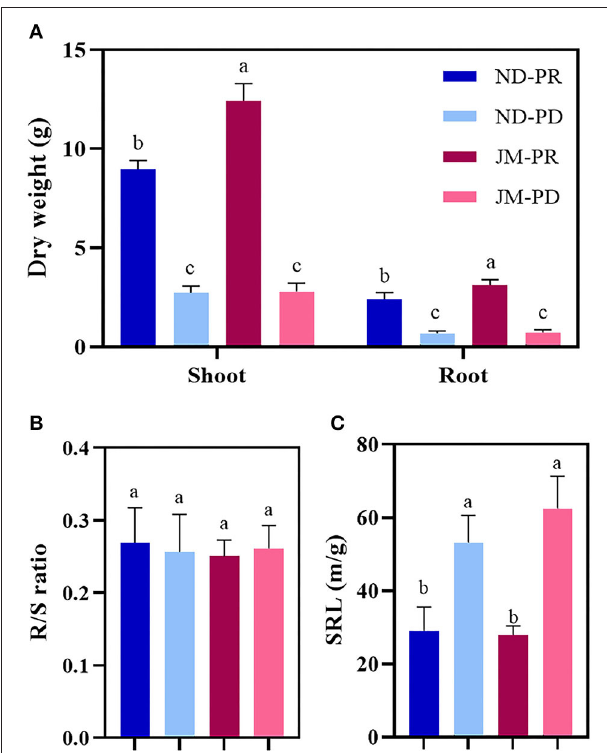
FIGURE 3 | Effect of phosphorus stress on shoot and root dry weight of two cotton cultivars (A) , root/shoot ratio (R/S ratio) (B) , and specific root length (SRL) (C) . ND-PR, “Nongdamian No. 10” cultivar under replete phosphorus conditions; ND-PD, “Nongdamian No. 10” cultivar under low phosphorus; JM-PR, “Jimian 315” cultivar under replete phosphorus conditions; JM-PD, “Jimian 315” cultivar under low phosphorus. Depicted are the means of six replicates ± standard errors. For each trait, bars with the same letter are not significantly different according to Duncan’s test at a P < 0.05 threshold.